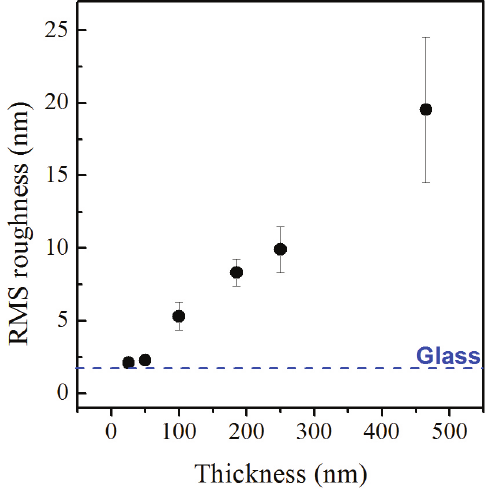
Figure 4. RMS roughness of the ZnO:Al films as a function of the film